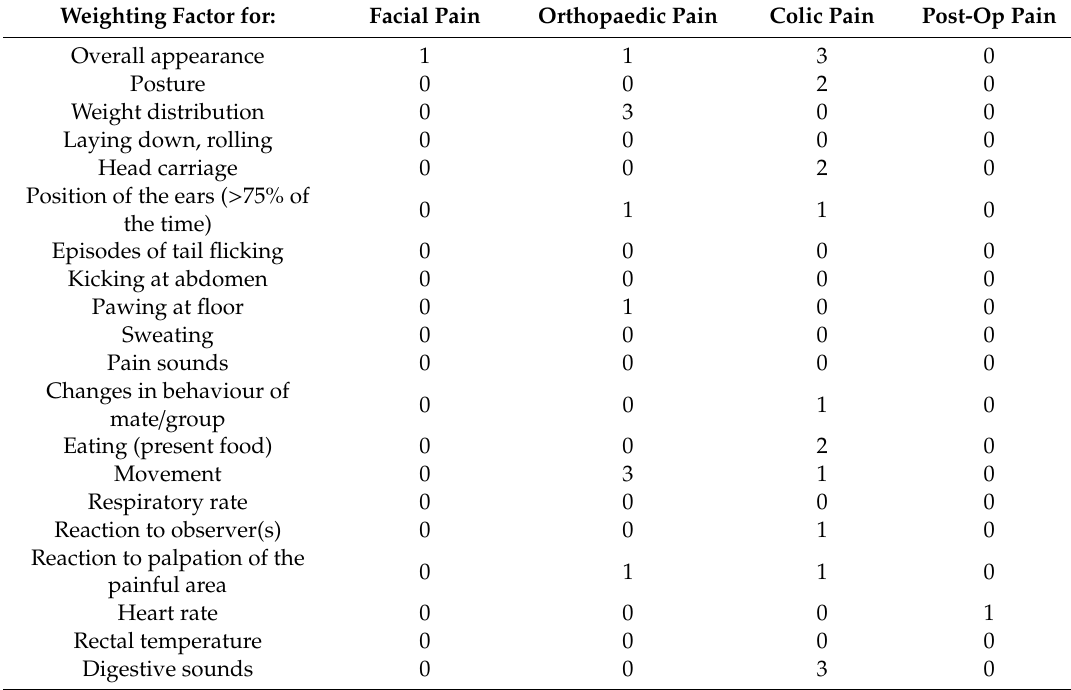
Table 5. Weighting factors of individual parameters of